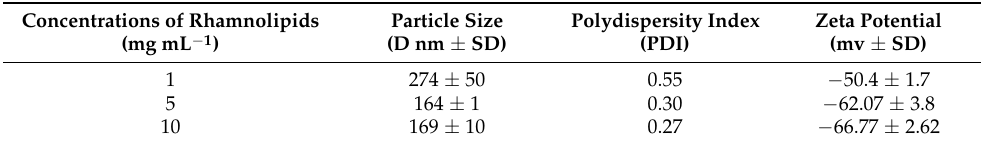
Table 2. Characterization of Rha(s) nano-micelles prepared at different concentrations; 1, 5 and 10 mg mL − 1 in PBS